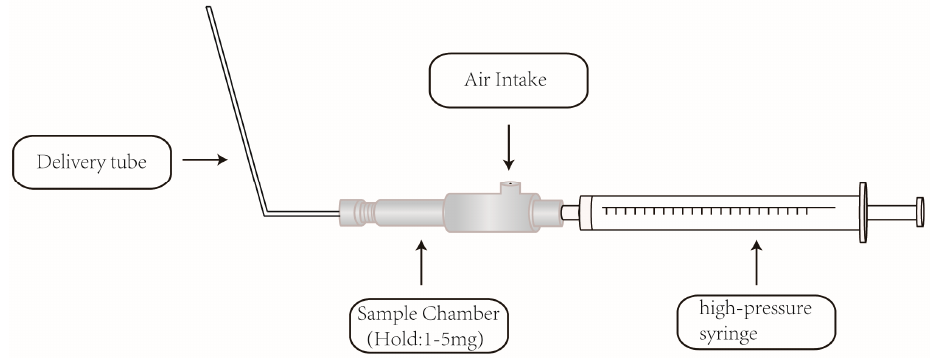
Figure 5. The schematic diagram of the pulmonary drug delivery device.